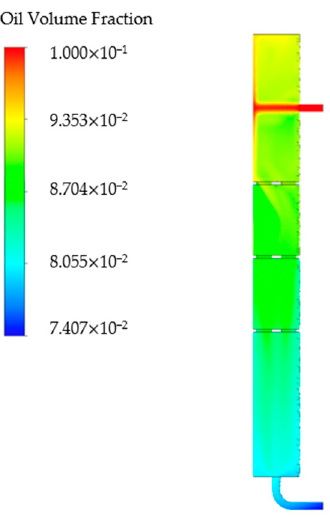
Figure 9. Oil phase volume distribution of seven-hole plate